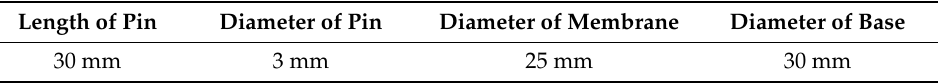
Table 2. The size parameters of the prototype.